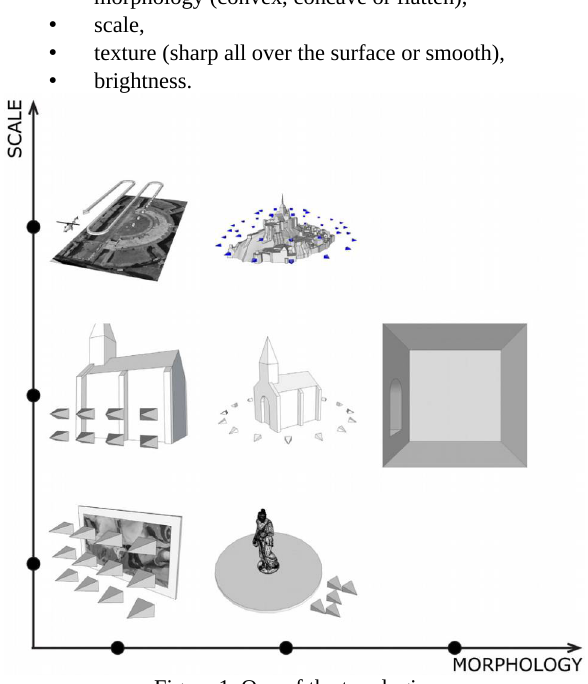
acquisition.Figure 1. One of the